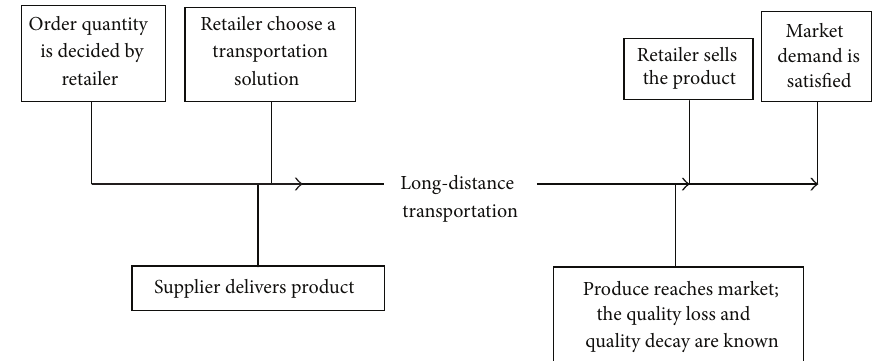
Figure 1: Timeline of decisions in the fresh produce supply